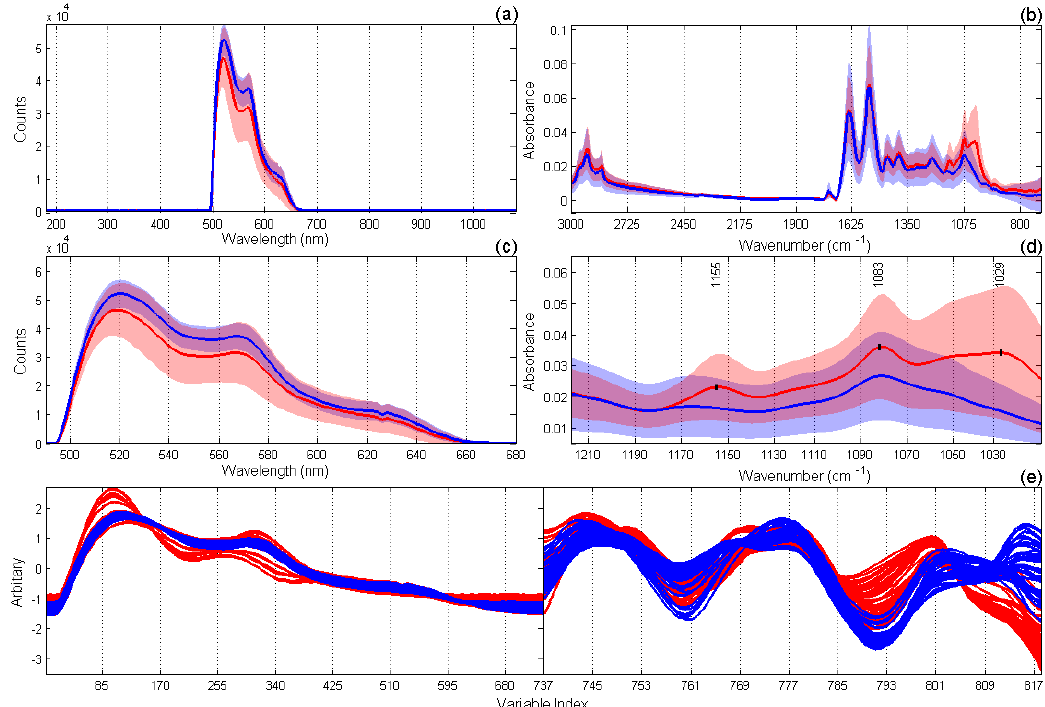
Figure 3. Spectral data: ( a ) raw fluorescence spectra; ( b ) raw mid infrared (MIR) spectra; ( c ) fluorescence spectra in the region of 490–680 nm; ( d ) MIR spectra in the region of 1220–1010 cm − 1 ; and ( e ) concatenated dataset of preprocessed fluorescence (left side) and MIR (right side) spectra. The following preprocessing was applied before data concatenation: standard normal variate (SNV) for fluorescence data and Savitzky-Golay second derivative followed by SNV for MIR spectra. Red and blue colors correspond to tumor and normal tissue samples, respectively. The curves and the surrounding colored regions in ( a – d ) represent the mean spectra and the standard deviation intervals of the respective data.